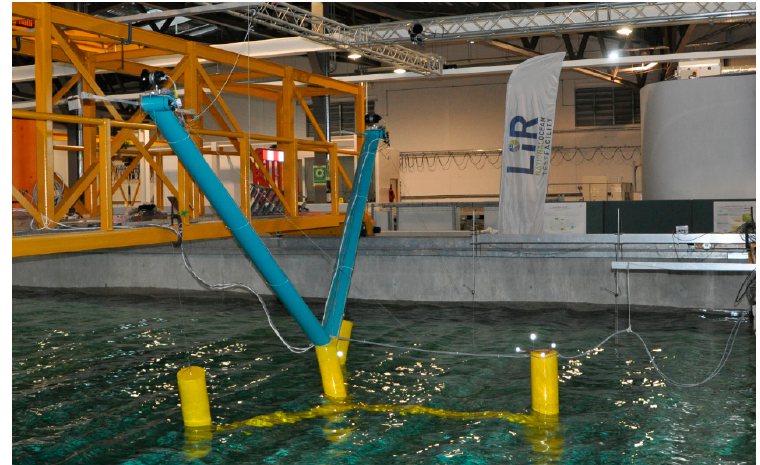
Figure 2. SCDnezzy 2 during testing at Lir NOTF. The Qualisys markers appear as points of light on the bow and tower.